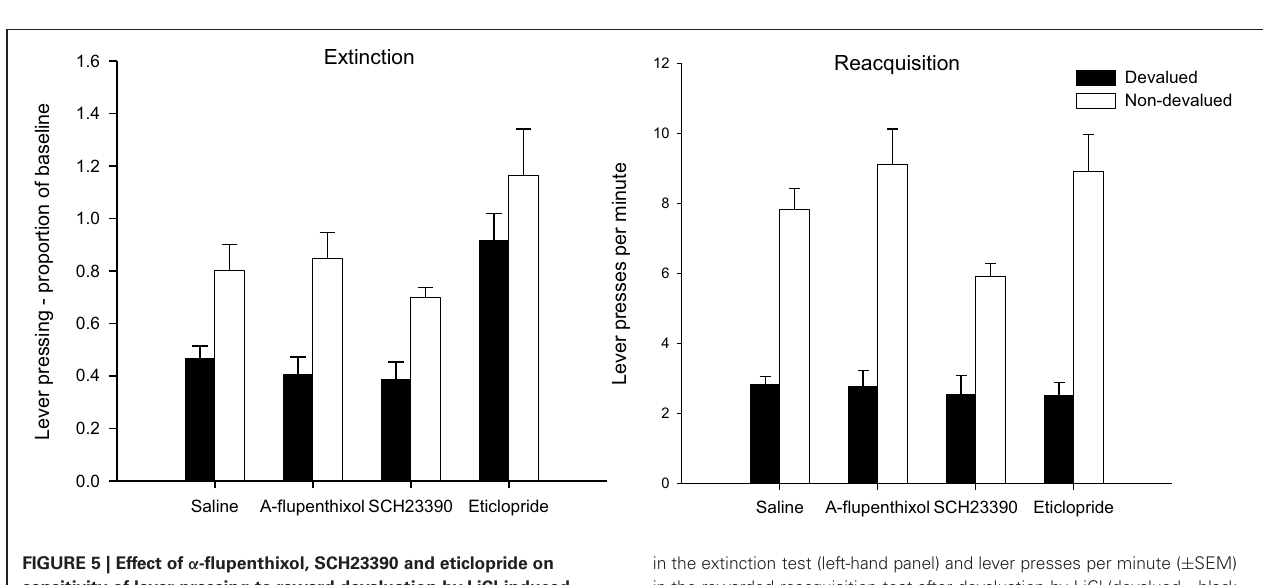
FIGURE 4 | Effect of eticlopride following amphetamine sensitization on sensitivity of lever pressing (left-hand panel) and magazine entry (right-hand panel) reacquisition after reward devaluation by LiCl-induced nausea. Mean lever presses per